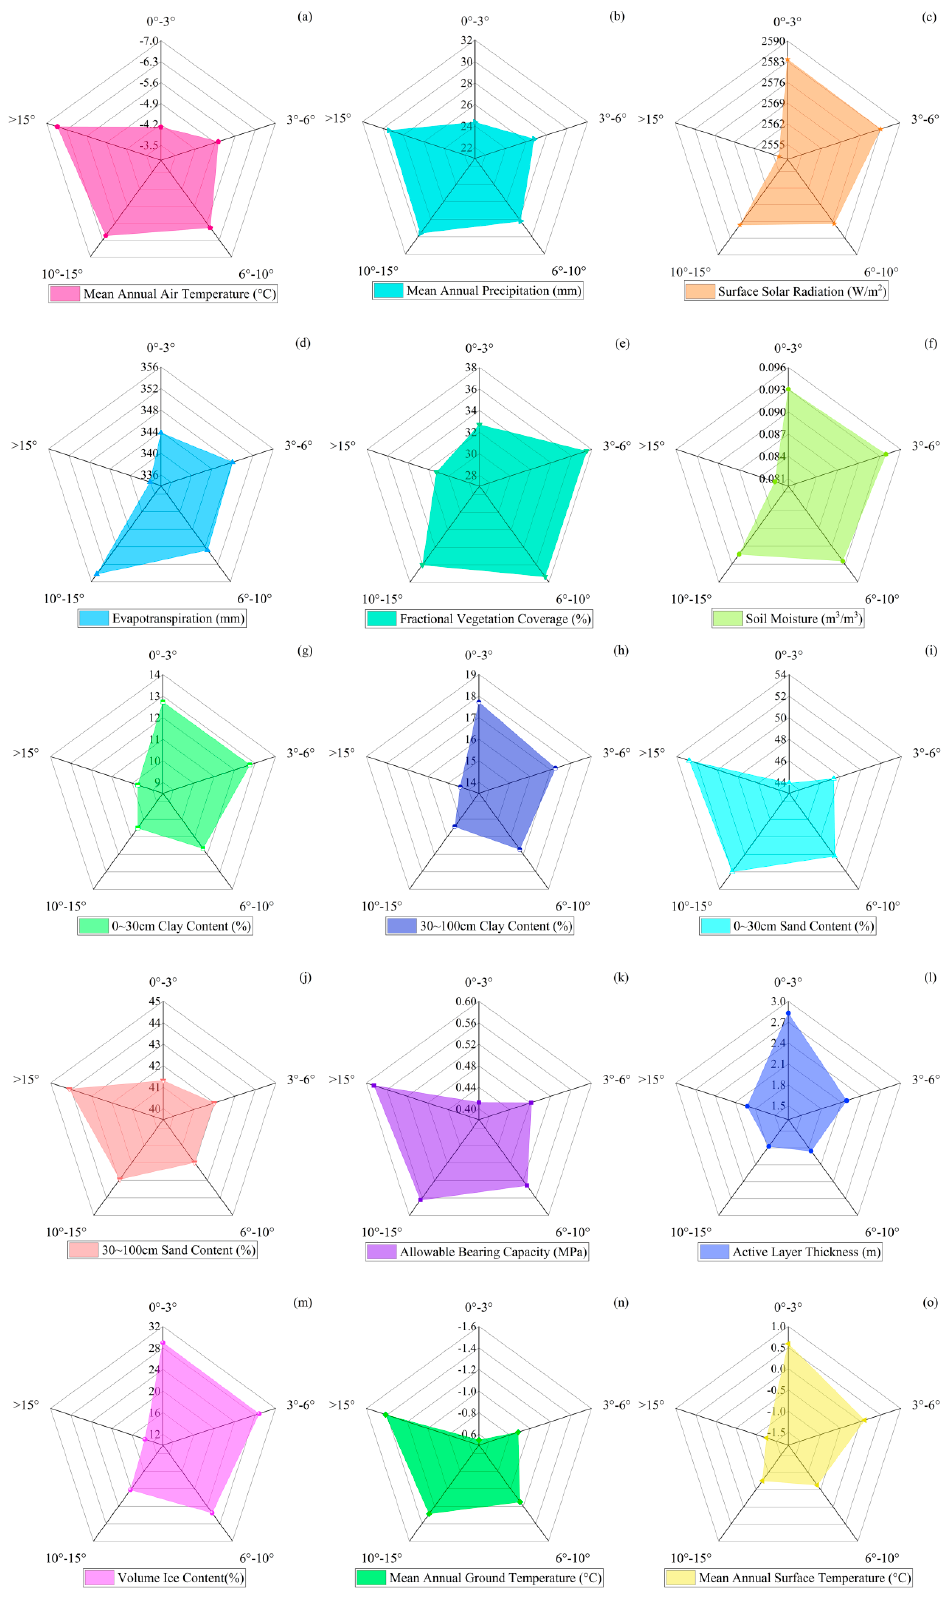
Figure 6. Changes in risk factors considering slope: ( a ) MAAT; ( b ) MAP; ( c ) SR; ( d ) ET; ( e ) FVC; ( f ) SM; ( g ) CC1; ( h ) CC2; ( i ) SC1; ( j ) SC2; ( k ) ABC; ( l ) ALT; ( m ) VIC; ( n ) MAGT; ( o )